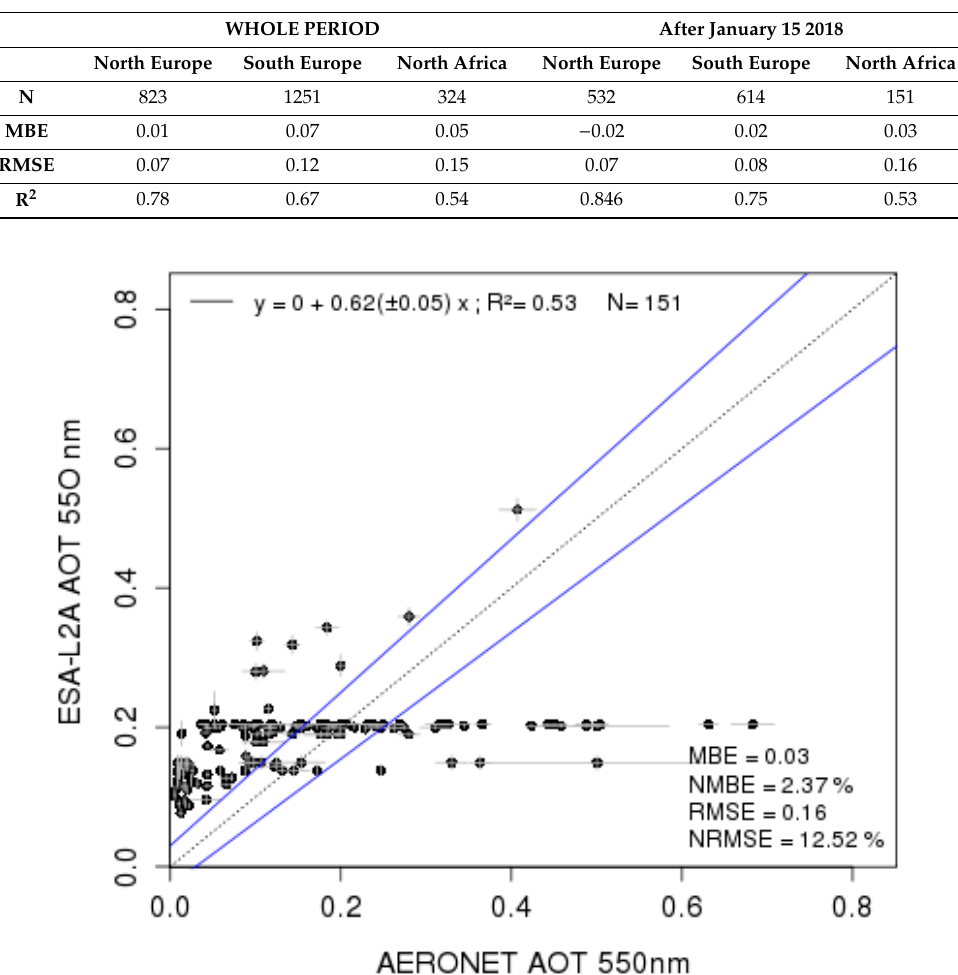
Figure 5. Scatter plot of AOT from ESA-L2A retrievals versus coincident AERONET Level 2.0 data for the sub-period after 15 January, 2018 in North Africa / Middle East region. The dashed grey line indicates the x = y line and the solid blue lines show the accuracy requirement limits (a) | ∆ AOT 550 | ≤ 0.1 × AOT 550 ref + 0.03, and (b) | ∆ IWV | ≤ 0.1 × IWV ref + 0.2 [21]. Table 6. MBE, RMSE and R 2 AOT values for di ff erent aerosol types (clean (CL), continental (CO), maritime (MA), forest fires emissions (FF) and desert dust (DD)) corresponding to the whole period and to the period after 15 January, 2018.